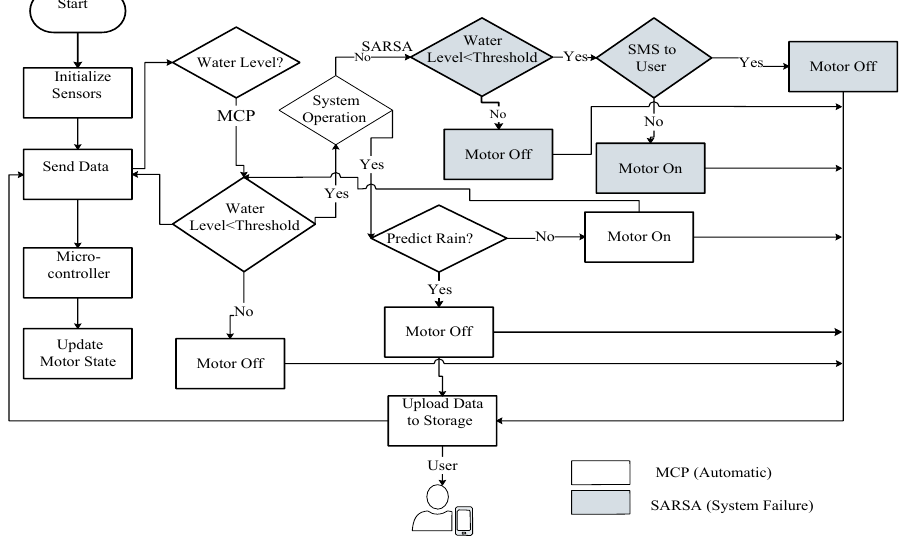
Figure 2. Flowchart of the irrigation optimization system. The white components are the actions of the fully functioning automatic system using a Markov chain process and the gray components are the path when the system operation has a failure and the SARSA approach is